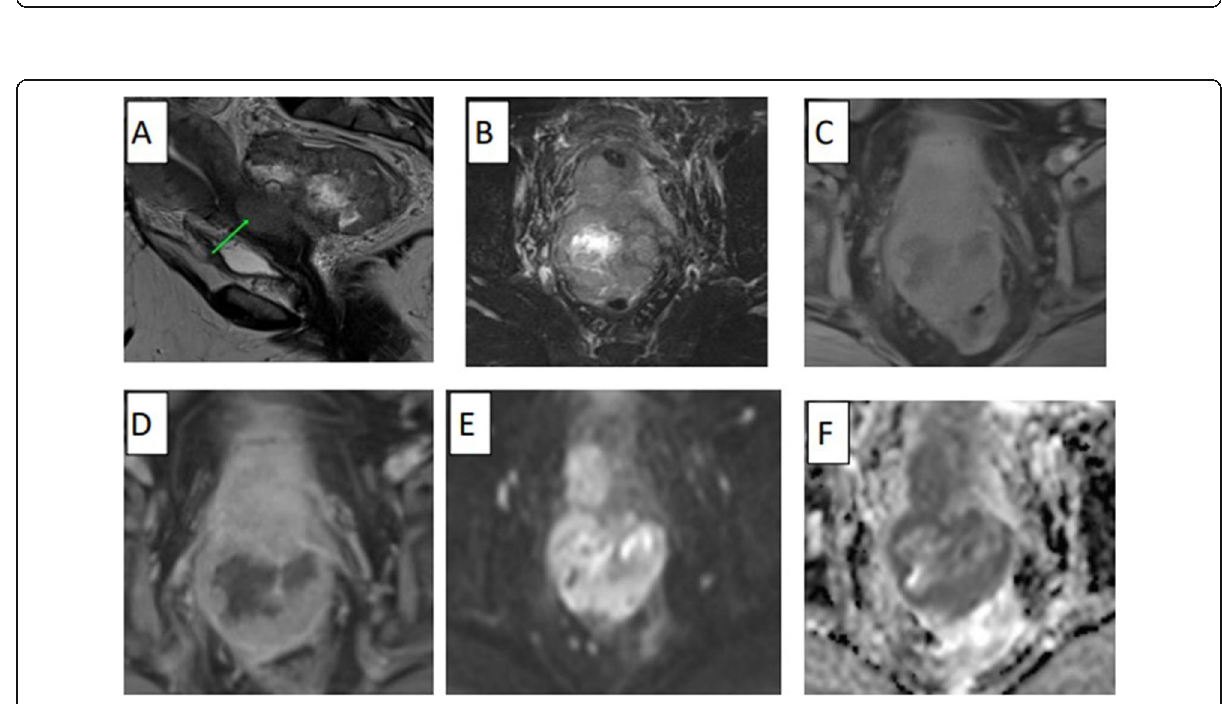
Fig. 3 Fifty-four-year-old female presented with constipation and bleeding per rectum. Colonoscopy and biopsy revealed rectal moderately differentiated adenocarcinoma. A Large lobulated circumferential soft tissue mass (measured 9 × 5 × 6.7 cm) was seen infiltrating the upper and middle thirds of rectum with anteriorly exophytic component invading the posterior wall of uterine cervix, best appreciated in sagittal T2- weighted image ( A ). It displayed heterogeneous high signal in T2WI ( B ) and intermediate signal in T1WI ( C ), with heterogeneous enhancement in post contrast images ( D ). The lesion appeared bright in DWIs ( E ) and turned dark in the ADC map ( F ), with ADC value 1.0 × 10 − 3 mm 2 /s, indicating restricted